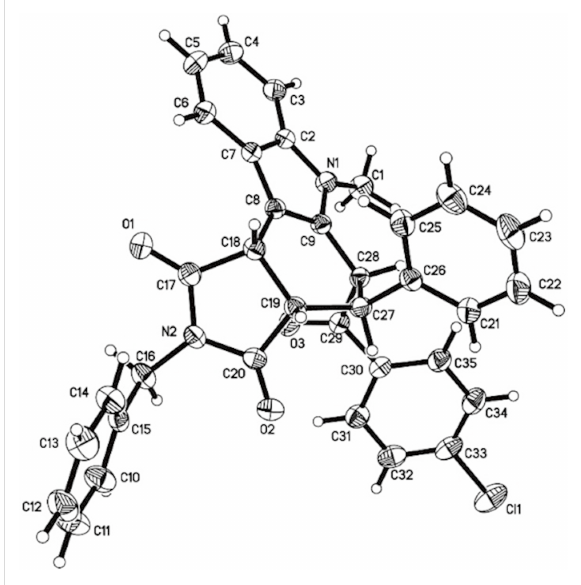
Figure 3: Single crystal structure of the isomer 3b